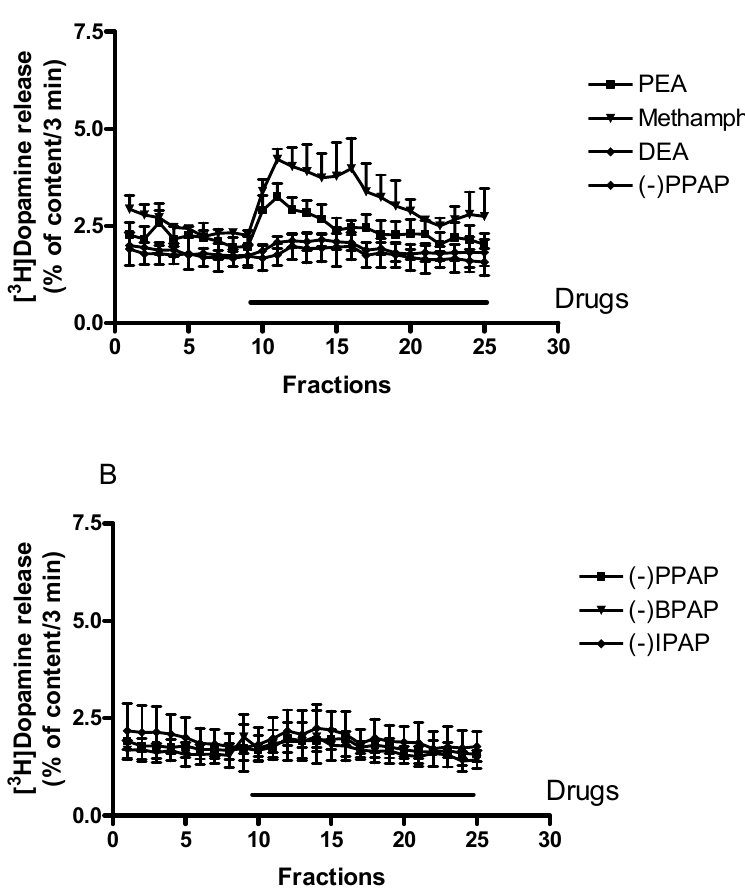
Figure 3. Effects of phenylethylamine derivatives on resting [ 3 H]dopamine release from rat striatum. For the experimental procedure, see Figure 2B. ( A ) The trace amine phenylethylamine (PEA) and the releaser ( ± )methamphetamine (methamph) induced non-vesicular [ 3 H]dopamine release, whereas N, α -diethylphenylethylamine (DEA) and the enhancer compound ( − )PPAP were without effect on [ 3 H]dopamine release. Drugs were added to rat striatal slices from fraction 10 in a concentration of 10 µ mol/L, (( ± )methamphetamine 6.75 µ mol/L) and maintained through the experiment, mean ± S.E.M., n = 4. ( B ) The enhancer compounds ( − )PPAP, ( − )IPAP, and ( − )BPAP were without effect on non-vesicular [ 3 H]dopamine release. Drugs were added to rat striatal slices from fraction 10 in a concentration of 10 µ mol/L and maintained through the experiment, mean ± S.E.M., n = 4. The control for Figure 3A,B is shown in Figure 2B.